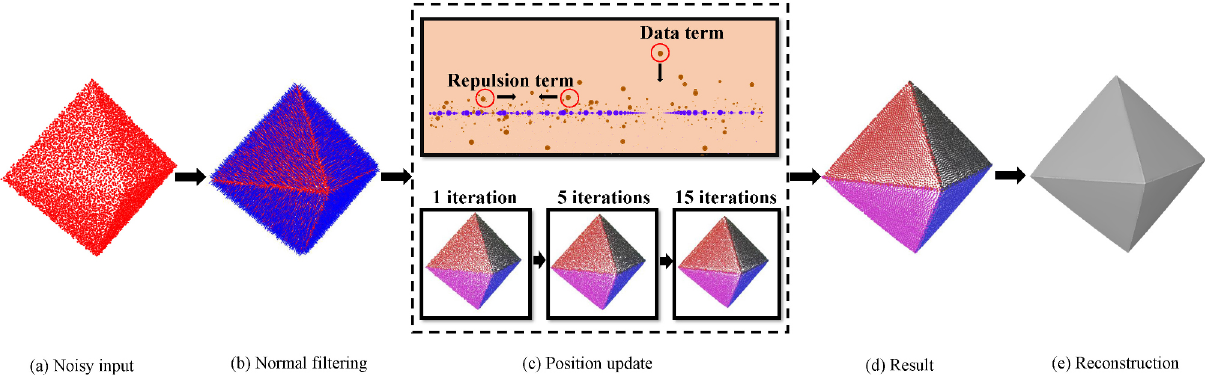
Fig. 1 Approach. (a) Noisy input. Red points are corrupted with noise. (b) Filtered normals. Blue lines are filtered results of the initial normals. (c) Position update method, using a data term for feature preservation and a repulsion term for uniform distribution. Multiple iterations are performed to achieve a better filtered result. (d) Filtered point cloud. (e) Mesh reconstructed from